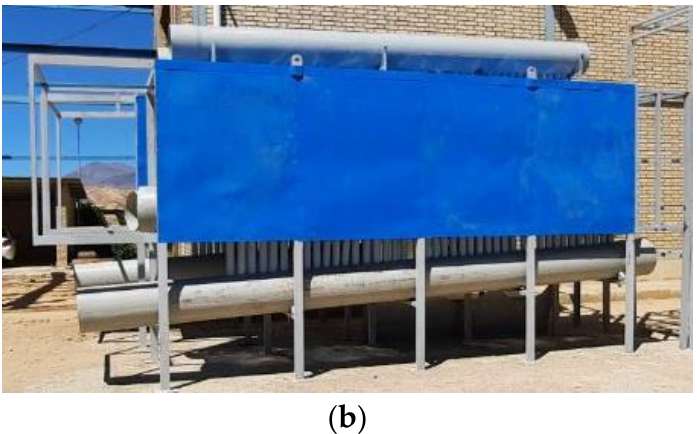
Figure 2. The arrangement of tubes in condensers ( a ) and two fabricated condensers ( b ).